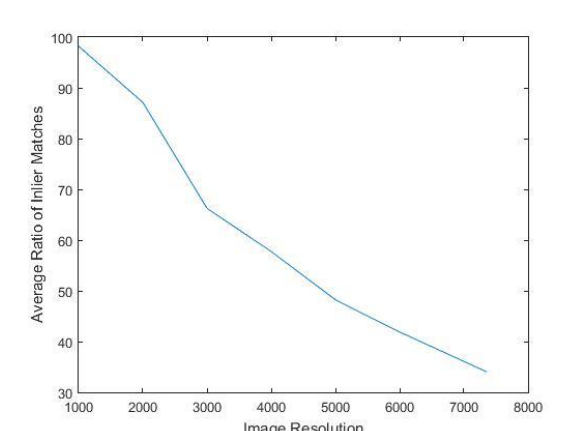
Figure 10. Average ratio of inlier matches of different resolution image sets